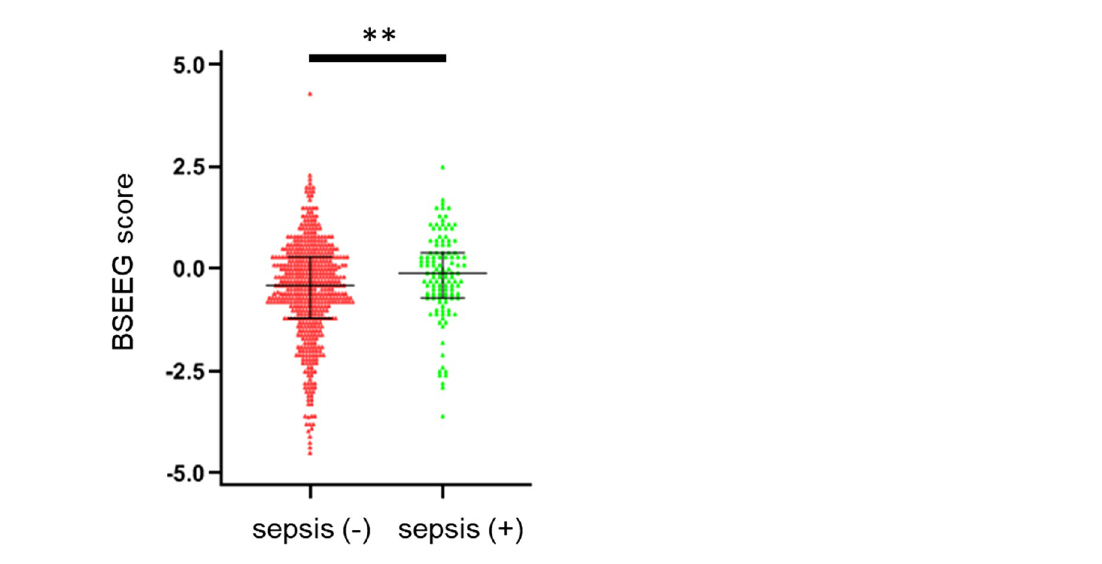
Figure 2. Comparison of 1st BSEEG score among two groups based on sepsis status. The data are presented as scatter plots including median and interquartile range. Mann–Whitney’s U -test was performed to compare the two groups. ** p < 0.01, sepsis (−): sepsis-negative, sepsis (+):